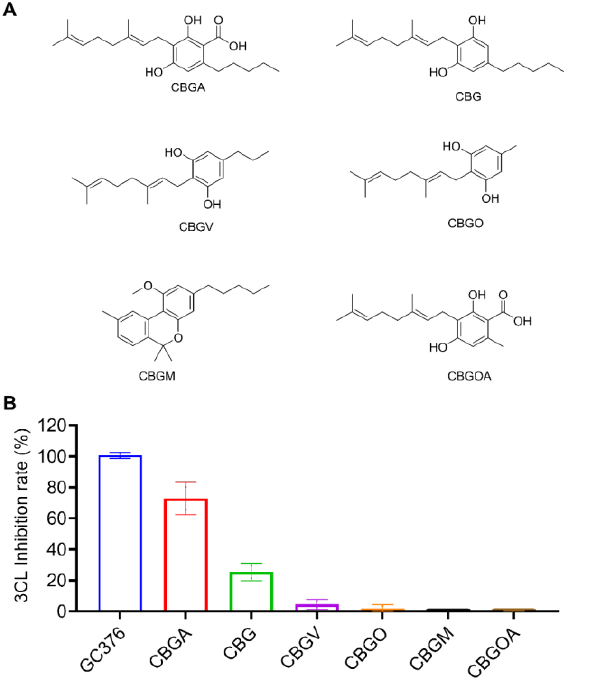
Figure 2. The chemical structures of the CBG-type of cannabinoids ( A ) and their inhibitory effect on the activity of SARS-CoV-2 M pro ( B ). These cannabinoids were tested at a concentration of 10 μM with the MBP-tagged SARS-CoV-2 M pro inhibition assay. GC376 was used as the positive control and each test compound was assayed in triplicate.